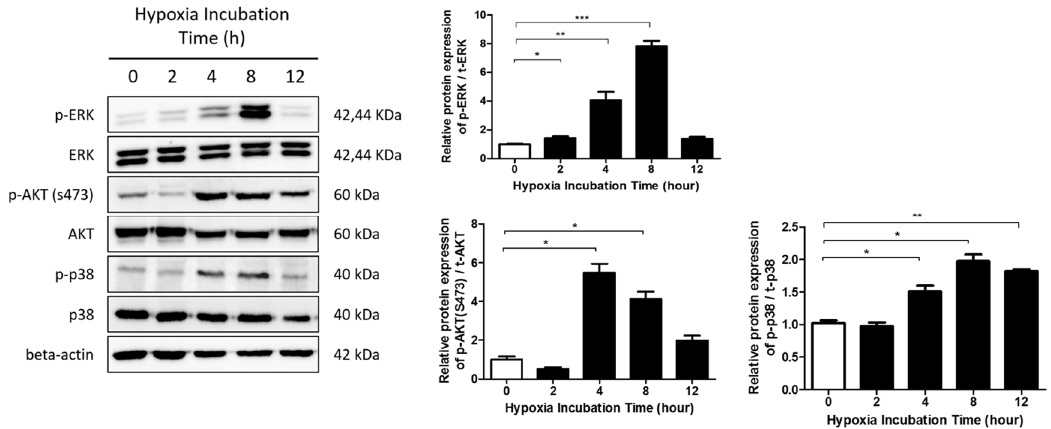
Figure 4. Involvement of the ERK/mitogen-activated protein kinase (MAPK) pathway in hypoxia- induced HIF-1α transcription. ERK phosphorylation was noted up to 8 h exposure to hypoxia. The AKT and p38 pathways were activated upon exposure to hypoxia for 12 h. Graphs show the optical density ratios between the bands representing the phosphorylated and total protein. Data are shown as mean ± SD. * p < 0.05, ** p < 0.01, *** p < 0.001.